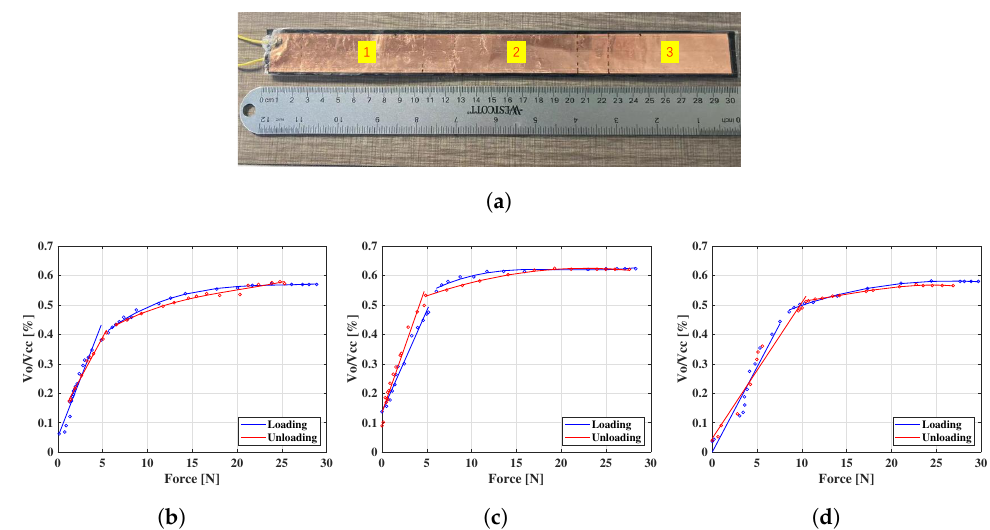
Figure 8. The sensitivity curves of the three parts of the FSU: ( a ) the location of the left, middle, and right portions of the FSU under the test of sensitivity curves; the curves from the ( b ) left part; ( c ) middle part; and ( d ) right part. After the load is more than approximately 25 N, the output ratio of the voltage divider Vo/Vcc is